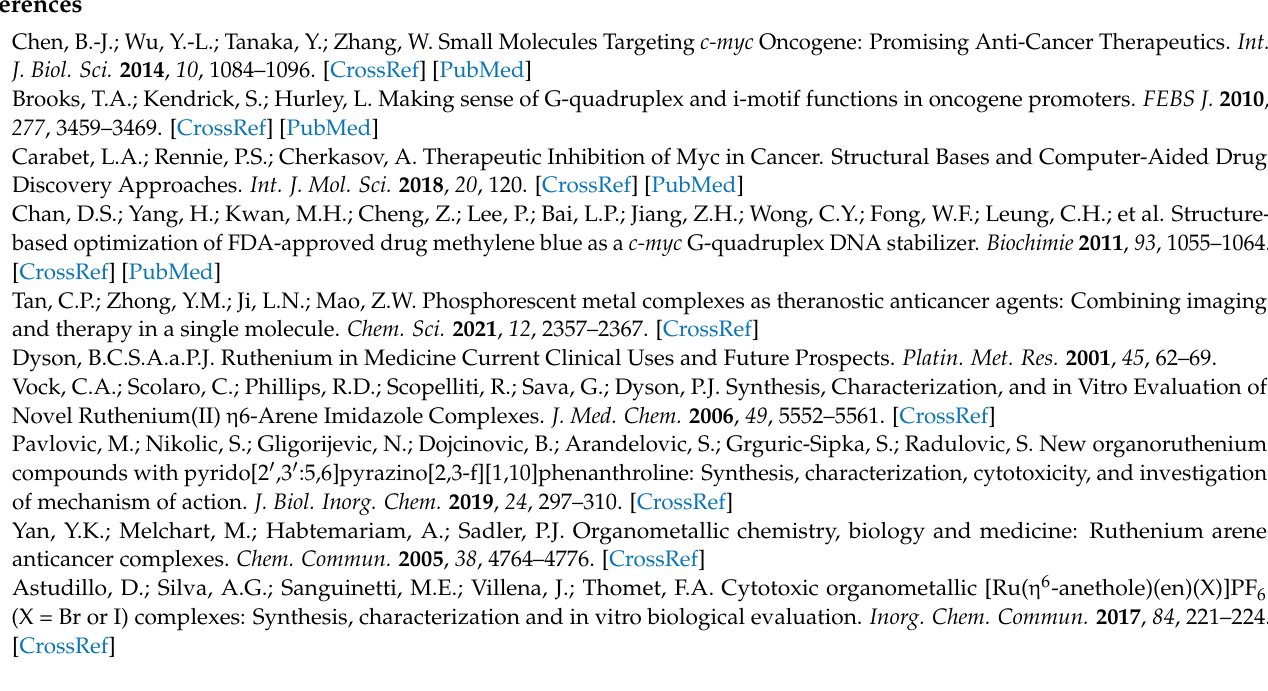
Figure S2: ESI-MS spectra of ligand L2, Figure S3: ESI-MS spectra of complex 1, Figure S4: ESI-MS spectra of complex 2, Figure S5: ESI-MS spectra of complex 3, Figure S6: ESI-MS spectra of complex 4, Figure S7: ESI-MS spectra of complex 5, Figure S8: ESI-MS spectra of complex 6, Figure S9: 1H- NMR and 13C-NMR spectra of ligand L1, Figure S10: 1H-NMR and 13C-NMR spectra of ligand L2, Figure S11: 1H-NMR spectra of complex 1, Figure S12:1H-NMR and 13C-NMR spectra of complex 2, Figure S13: 1H-NMR and 13C-NMR spectra of complex 3, Figure S14: 1H-NMR and 13C-NMR spectra of complex 4, Figure S15: 1H-NMR and 13C-NMR spectra of complex 5, Figure S16: 1H-NMR spectra of Ru(II) complexes 6, Figure S17: Effect of 6 on the PCR-stop assay with c-myc G4 DNA, Figure S18: The stability of complex 6 in a Tris buffer solution, Figure S19: Ligand(L2)-c myc G4 DNA interactions, Table S1: The cytotoxic activity of the ligands and arene (II)-modified compounds, Figure S20: Multiple gene expression in glioblastoma multiforme, Figure S21: Binding site and mode of the arene Ru(II) complexes that interacted with c-myc G-quadruplex DNA analyzed by molecular docking; Figure S22: The UV–vis absorption titrations of arene Ru(II) complexes modified with and without F